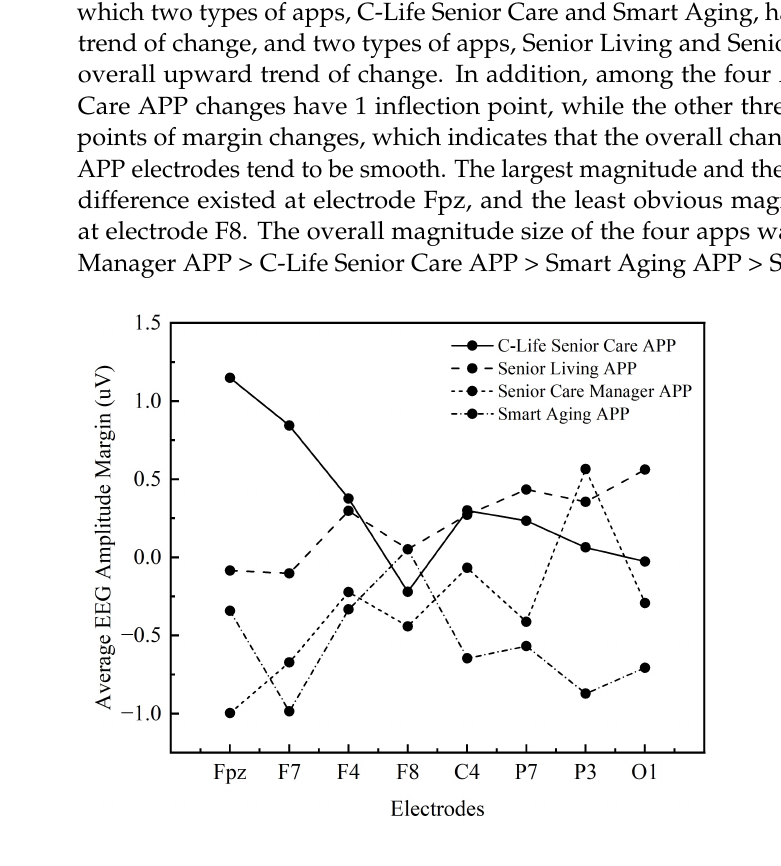
Figure 9. Marginal mean value of electrode